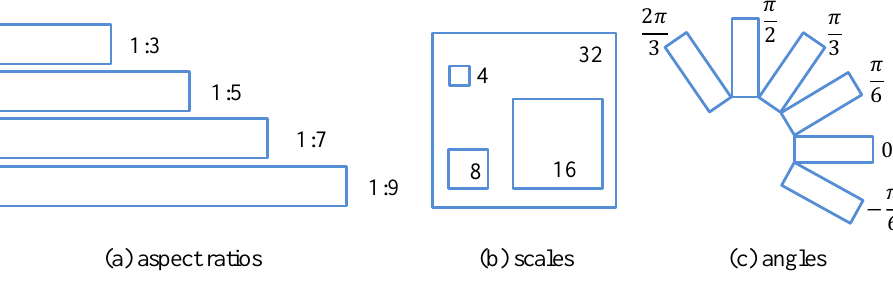
Figure 5. Anchor strategy used in our